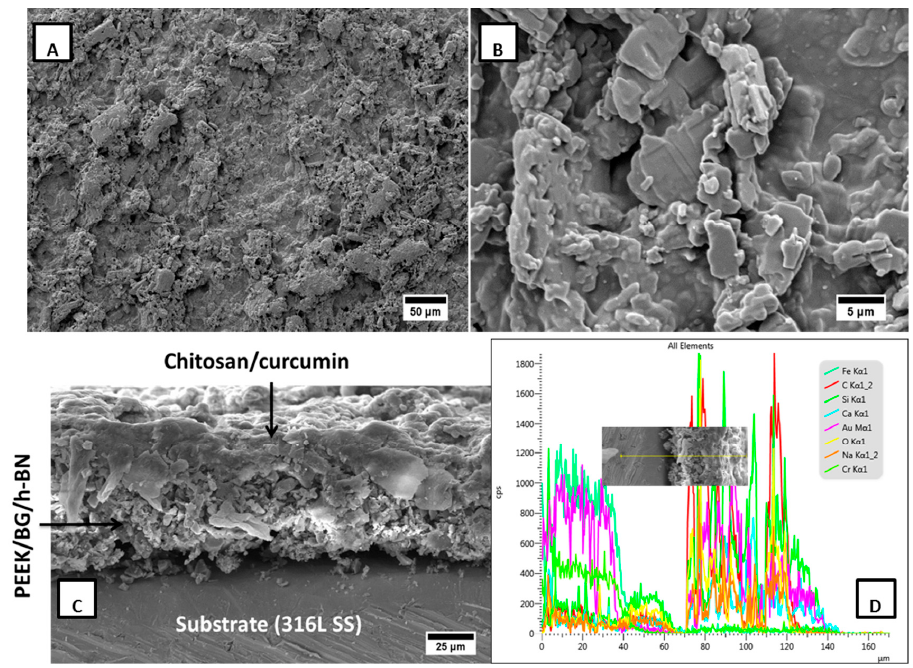
Figure 7. SEM micrographs for EPD of chitosan/curcumin composite coatings produced on PEEK/BG/h-BN layers at 20 V for 3 min at: ( A ) 500×, ( B ) 5000×, ( C ) cross-section, ( D ) compositional